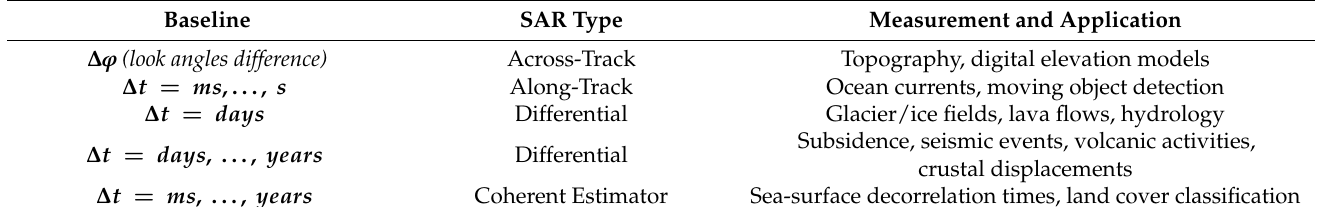
Table 1. Some baseline types for interferometric SAR [28].